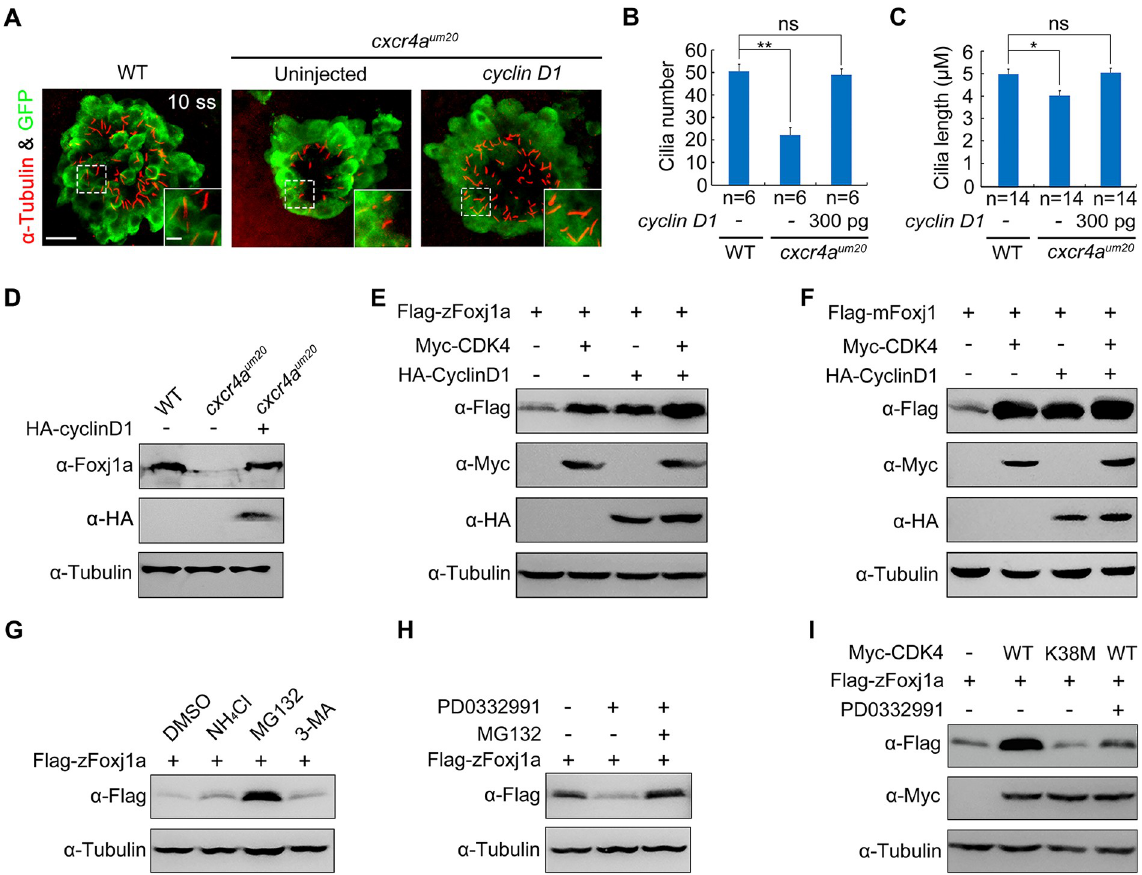
Fig 5. CDK4 stabilizes Foxj1 through its kinase activity. (A–C) Confocal images of 10-somite–stage cxcr4a -deficient Tg(sox17 : GFP) embryos injected with or without 300 pg cyclin D1 mRNA at the 256-cell stage (A). KV cells were labeled with antibodies against GFP (green), and cilia were visualized by α -Tubulin immunofluorescence (red). The boxed areas in the images are presented at higher magnification in the relevant insets. Scale bar, 20 μ m. Cilia number (B) and length (C) were analyzed. Student t test, � P < 0.05, �� P < 0.01. Note that when cyclin D1 mRNA was injected into cxcr4a -deficient DFCs, both the KV cilia number and length were restored. Underlying data can be found in S1 Data. (D) Western blots of total lysates from 75%-epiboly–stage WT embryos and cxcr4a um20 mutants injected with or without 300 pg HA-cyclin D1 mRNA at the 256-cell stage. Tubulin was used as the loading control. Endogenous zFoxj1a protein levels in cxcr4a um20 mutants was rescued by DFC-specific overexpression of HA-cyclin D1 . (E–F) CDK4 overexpression alone or together with Cyclin D1 results in an obvious increase in zFoxj1a (E) or mFoxj1 (F) expression. HEK293T cells were transfected with the indicated plasmids. Lysates were analyzed by western blot using the indicated antibodies. (G) HEK293T cells transfected with plasmids encoding Flag-zFoxj1a were treated with the lysozyme inhibitor NH4Cl (20 mM) or the proteasomal inhibitor MG132 (20 μ M) or the autophagy inhibitor 3-MA (5 mM) for 5 hours prior to harvest for immunoblotting. (H) Lysates from Flag-zFoxj1a–expressing HEK293T cells treated with CDK4/6 inhibitor PD0332991 (0.5 μ M) alone or in combination with MG132 (20 μ M) were subjected to immunoblotting. (I) Overexpression of WT CDK4 , but not its kinase-deficient mutant, stabilizes zFoxj1a protein. HEK293T cells were transfected with the indicated plasmids. PD0332991 (0.5 μ M) was added 5 hours before harvest. Note that PD0332991 treatment blocked CDK4-induced zFoxj1a stabilization. CDK, cyclin-dependent kinase; DFC, dorsal forerunner cell; Foxj1a, forkhead box j1a; GFP, green fluorescent protein; HA, hemagglutinin; HEK, human embryonic kidney; KV, Kupffer’s vesicle; mFoxj1, mouse Foxj1, mouse Foxj1; sox, SRY-box transcription factor; Tg, transgene; WT, wild-type; zFoxj1a, zebrafish Foxj1a; 3-MA, 3-methyladenine; α -Tubulin, acetylated